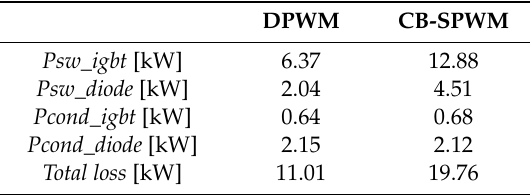
Table 3. Comparison of switches’ losses between DPWM and